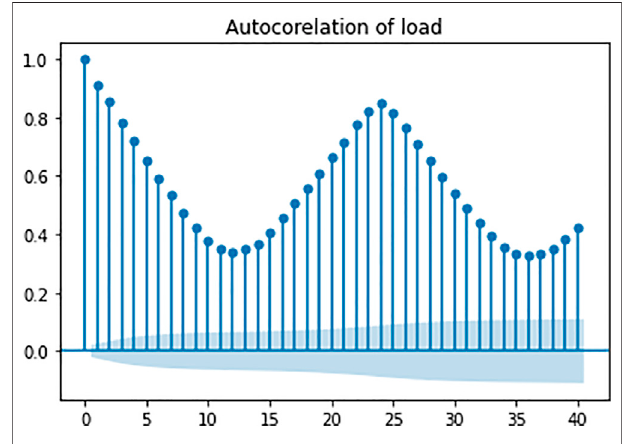
FIGURE 6 | Load autocorrelation analysis